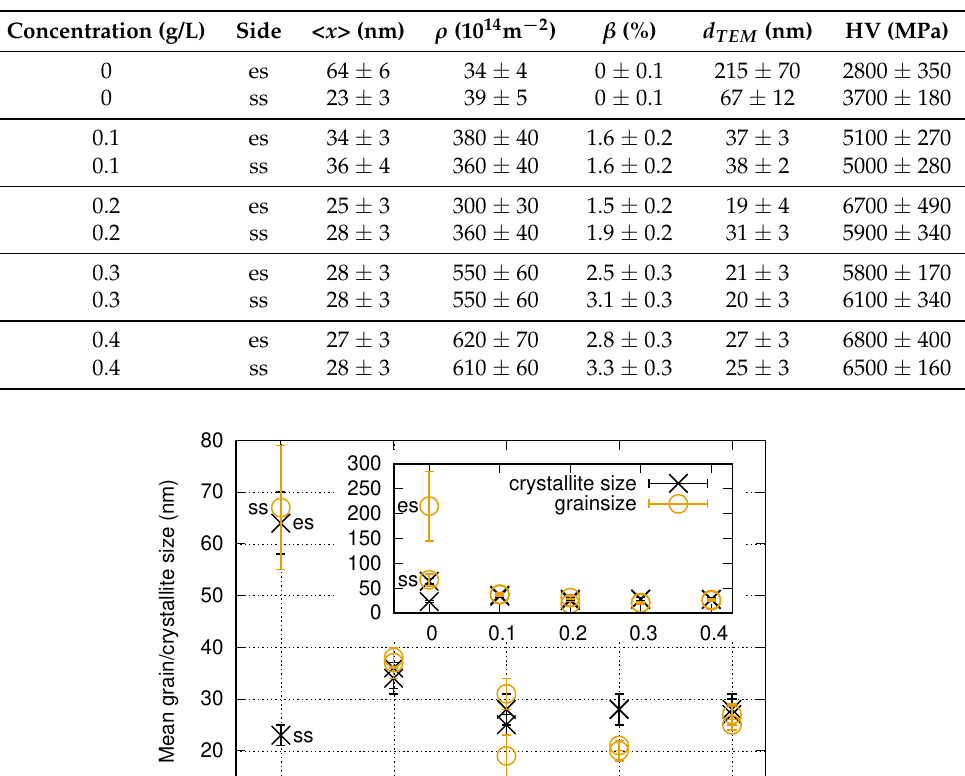
Table 2. Microstructural parameters and Vickers hardness (HV) of samples deposited from baths containing different amounts of cysteine. Both the electrolyte side (es) and the substrate side (ss) were investigated. The table contains the crystallite size (< x >), the dislocation density ( ρ ) and the twin fault probability ( β ) obtained by XLPA, as well as the mean grain size obtained from TEM ( d TEM ).